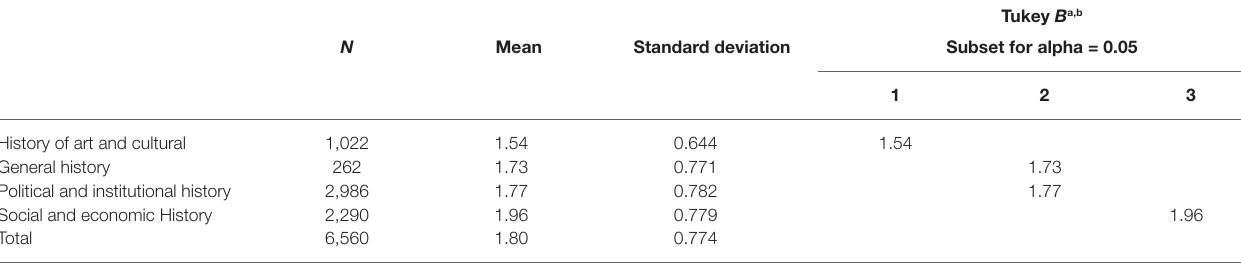
Table shows the means for the groups in the homogeneous subsets. a It uses the size of the sample of the harmonic mean = 718,540.